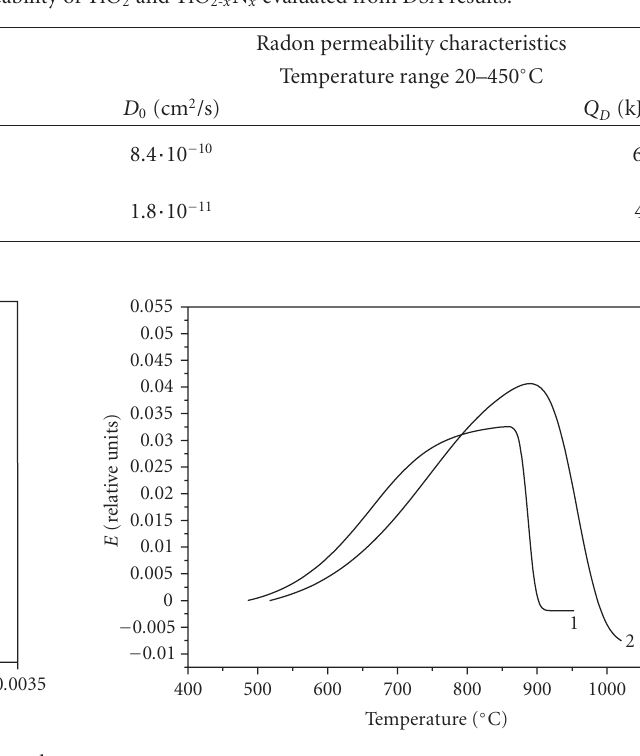
Figure 7: Model curves of the temperature dependences of the radon release rate E ( T ) for sample A (curve 1) and sample B (curve